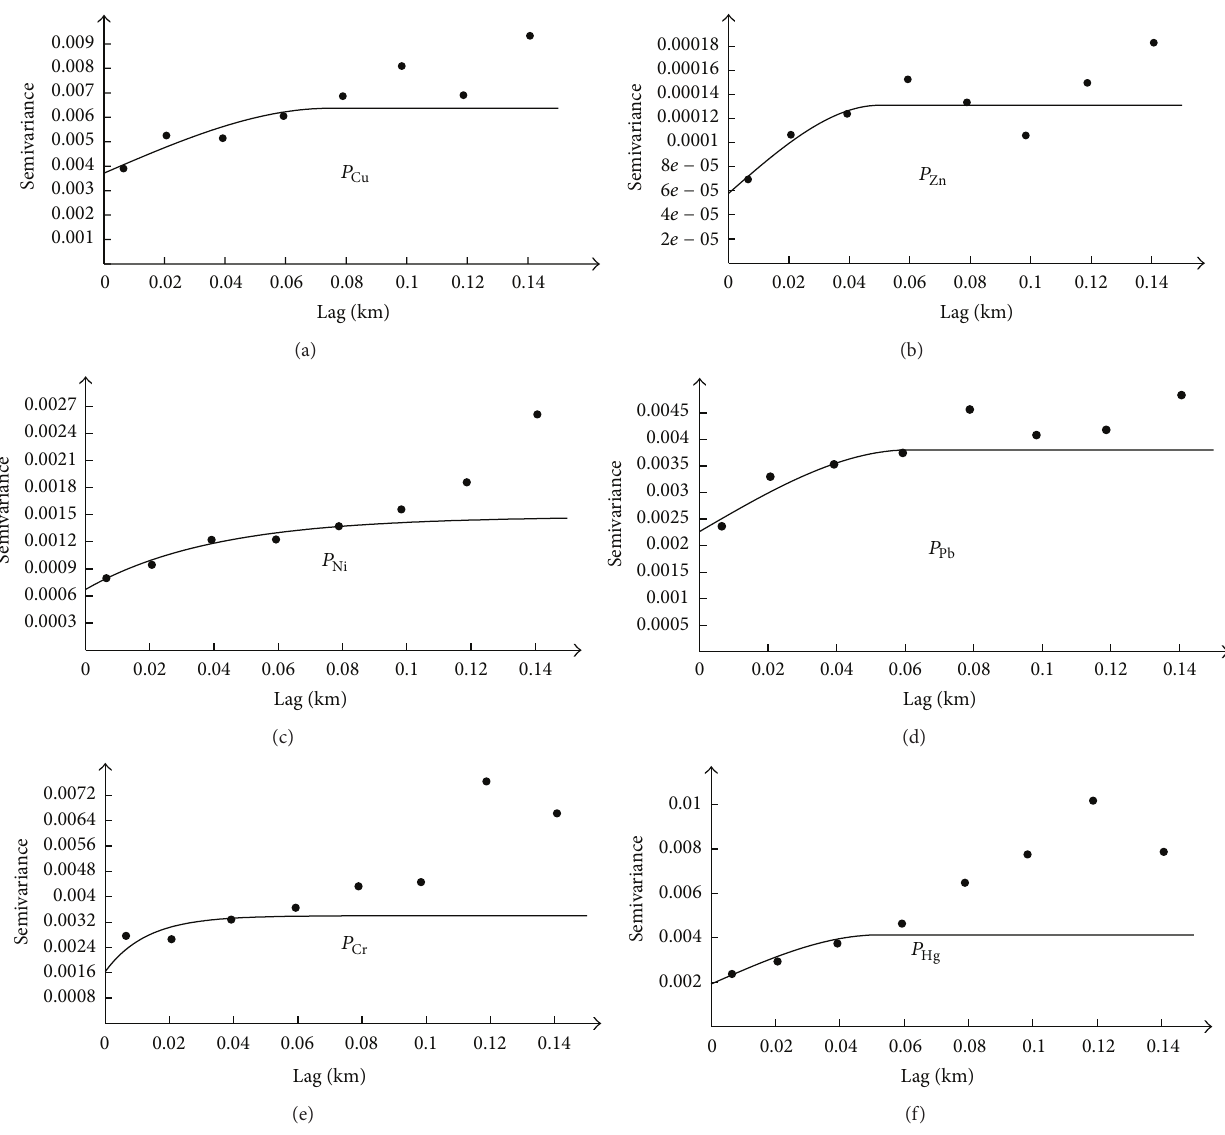
Figure 3: Semivariograms model of soil heavy metal single pollution index.